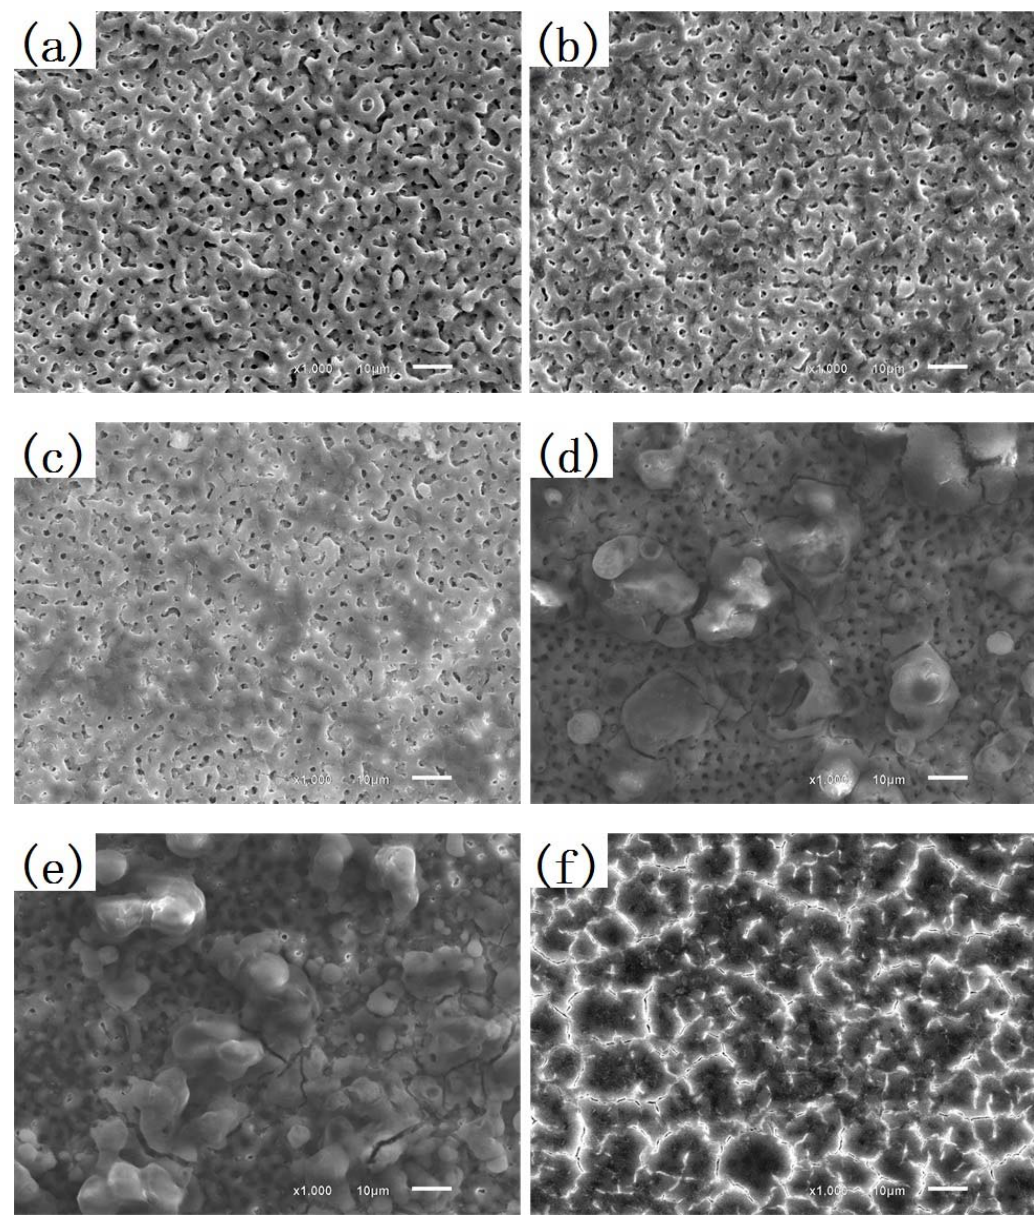
Figure 7. The surface morphology of MAO coatings after immersion in 3.5 wt % NaCl solution: ( a ) 24 h, ( b ) 48 h, ( c ) 96 h, ( d ) 192 h, ( e ) 384 h, and ( f ) 768 h.